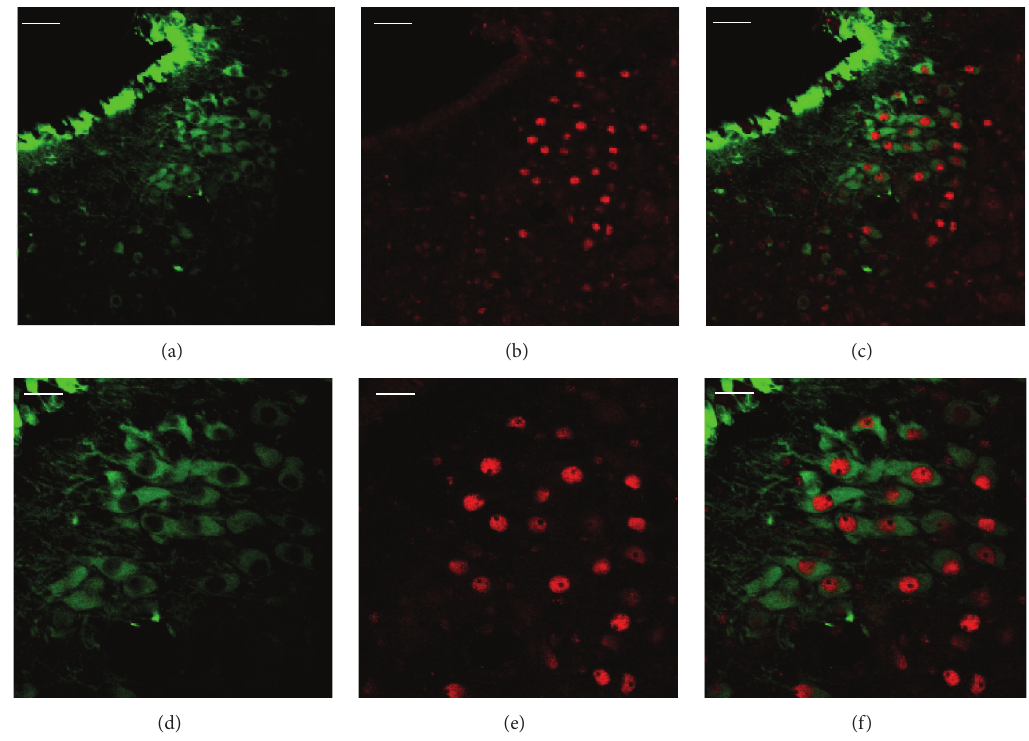
Figure 5: Localization of IL-4 and GR in the LC. (a–c) Representative fluorescent images showed that IL-4 (a) and GR (b) were expressed in the neurons but not in the identical part (c). Photomicrographs were taken at × 200 magnification. Scale bars = 50 𝜇 m. (d–f) High power (taken at × 400 magnification) photographs of (a), (b), and (c), respectively, are shown. Scale bars = 20 𝜇 m.